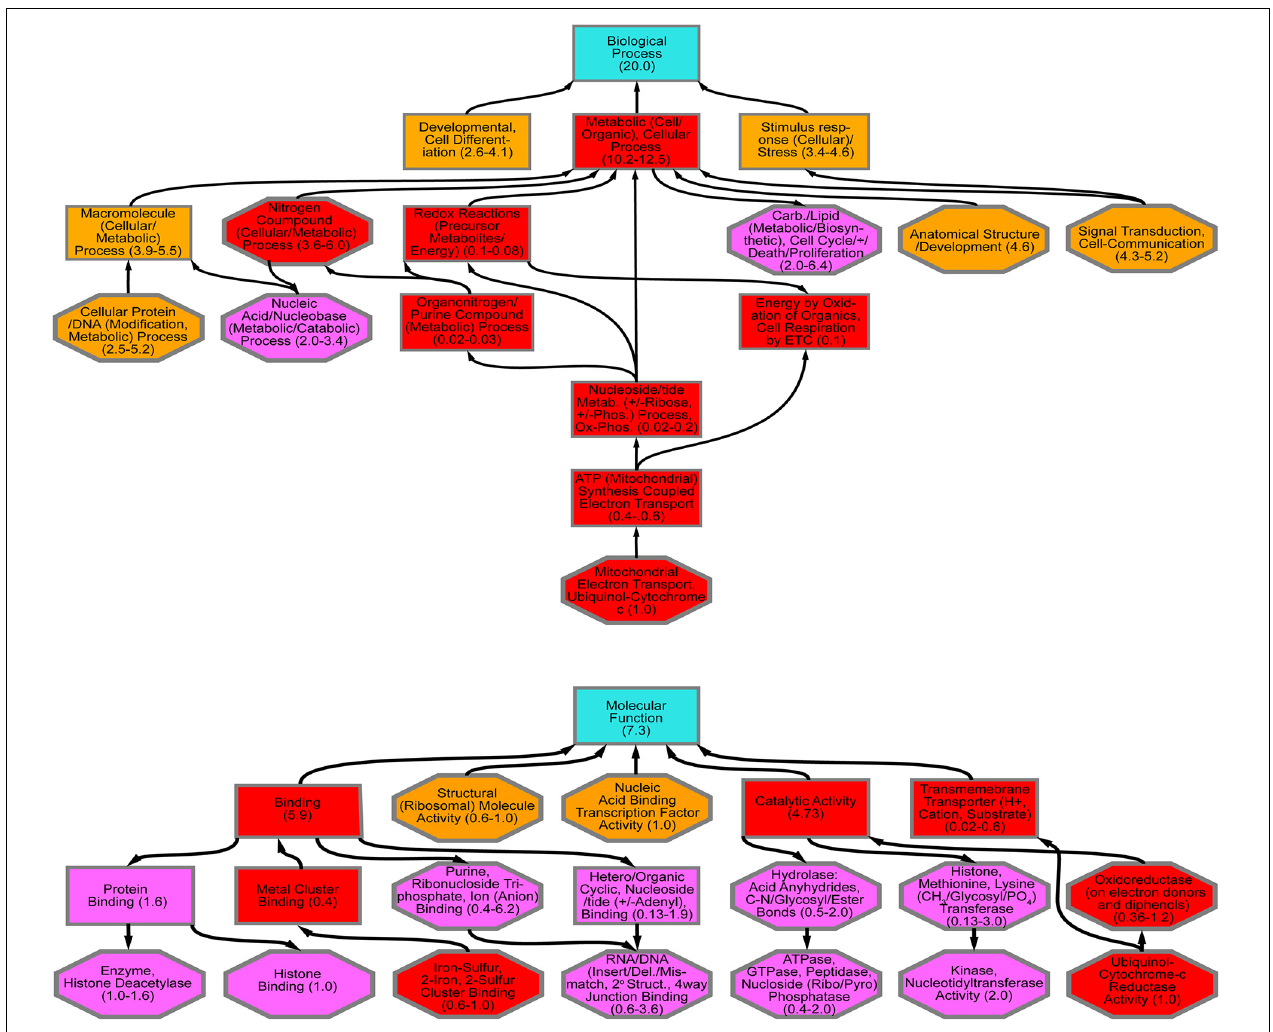
FIGURE 2 | GO Annotation of comparative RNA Seq Transcriptome analysis. Contigs with the most significant variations showing up or down transcriptional abundance were identified in D. citri gut transcriptome after feeding on C. macrophylla leaves engineered with CTV- RIE . Using two major categories of GO Ontology (Biological Process and Molecular Function upper and lower hierarchical maps, respectively). The hierarchical maps show groups of contig specific annotations (in octagons) linked by shared functions or processes (in rectangles) each with a range of node scores in parenthesis. Each term in an octagon or rectangle is associated with a node score [Node Score = (no. of sequences) × α dist , with α = constant = 0.6, dist = a measure of the relative association to the node term]. Annotations of the contig identified as the Rieske gene are contained in the lowest octagons in each map above. Upward arrows connect to other red rectangles and octagons and represent “downstream” effects. Downward arrows (from red shapes) connect to magenta shapes that represent “upstream effects.” Orange shapes contain terms that are not (or have not yet been) associated with downstream effects of dsRNA- RIE. TABLE 1 | Statistical analysis of D. citri mortality of the top three dsRNAs fed by artificial diet showing dose response ( Figure 1B ).